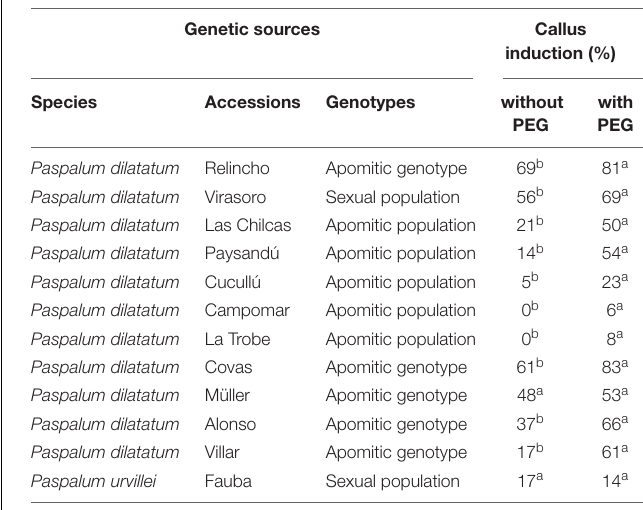
TABLE 1 | Proportion of induced embryogenic calli (EC) (number of induced calli/Number of explants), from seeds (pretreated or not pretreated with PEG) from different genetic sources.